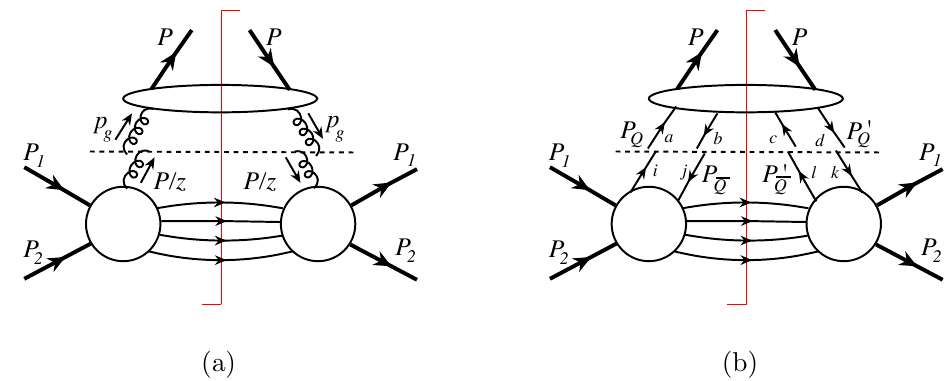
FIG. 4: These generic Feynman diagrams represent alternative heavy quarkonium production processes, via the production of a single parton, here a gluon, (left) and a heavy quark pair (right) at short